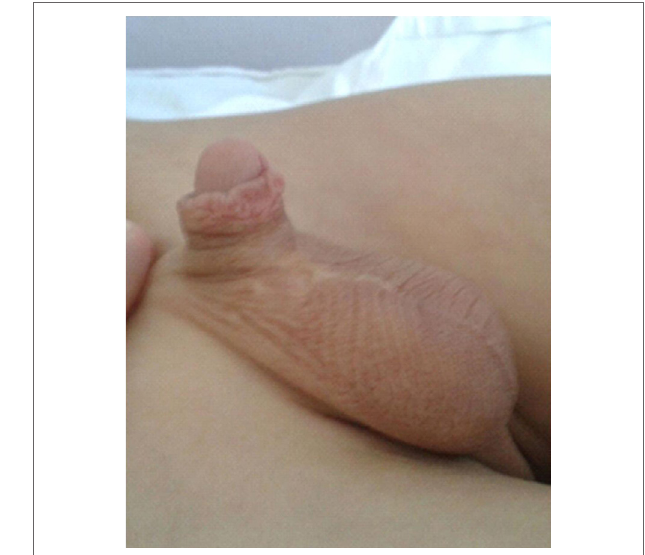
FigUre 5 | Genitalia appearance after immediate megaprepuce